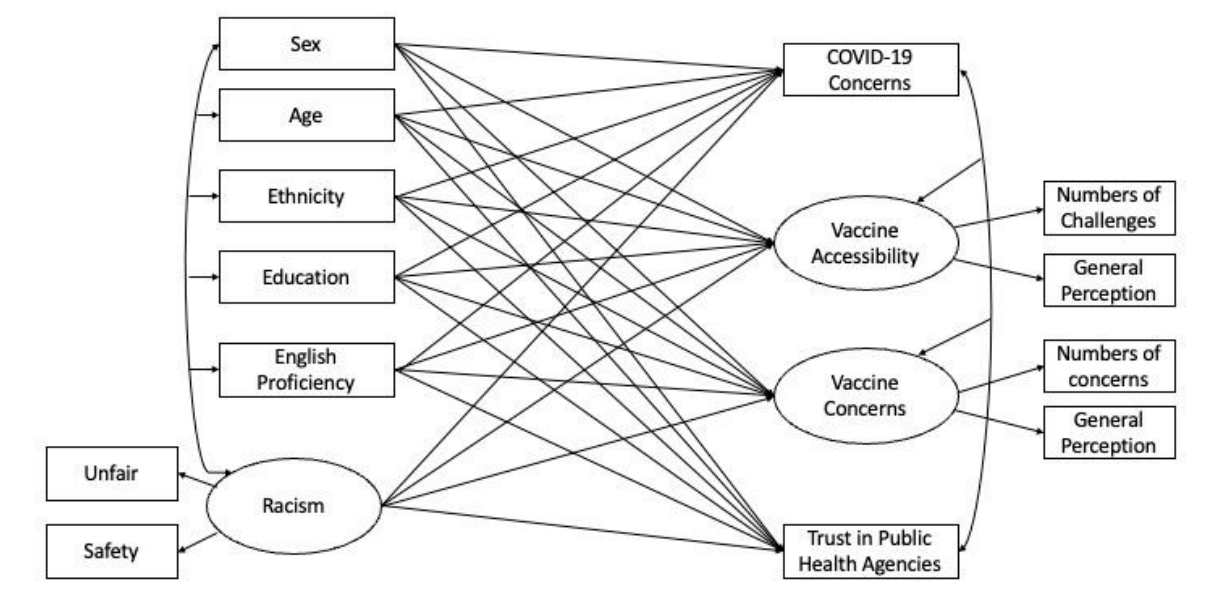
Figure 1. Structural equation model (SEM) predicting general COVID-19 concerns, COVID-19 vaccine accessibility, COVID-19 vaccine concerns, and trust in public health agencies using demographic characteristics and racism experience. The shared variance ( r 2 ) between indicators formed the latent variable: (b) vaccine accessibility = 0.08; (c) vaccine concerns = 0.14; and (3) racism = 0.30. These statistics indicate the association and hence internal consistency among the items [30].